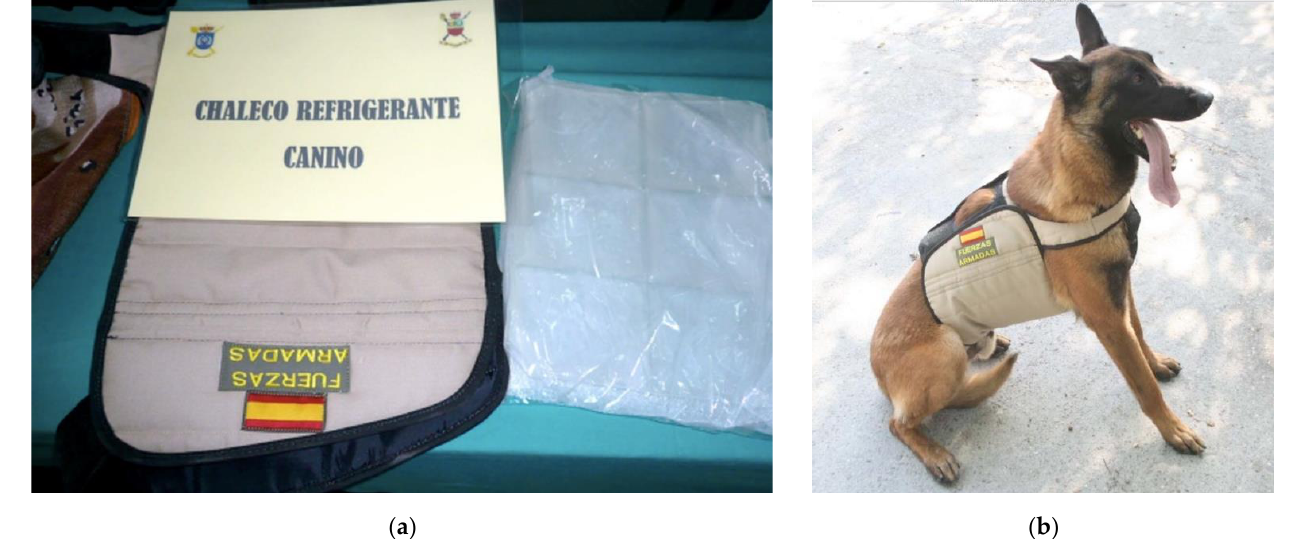
Figure 3. ( a ) Close-up of cooling vest (PCM-CV) with cooling pads. ( b ) An MWD wearing a PCM-CV. They require prior cooling (or freezing) of the pads.